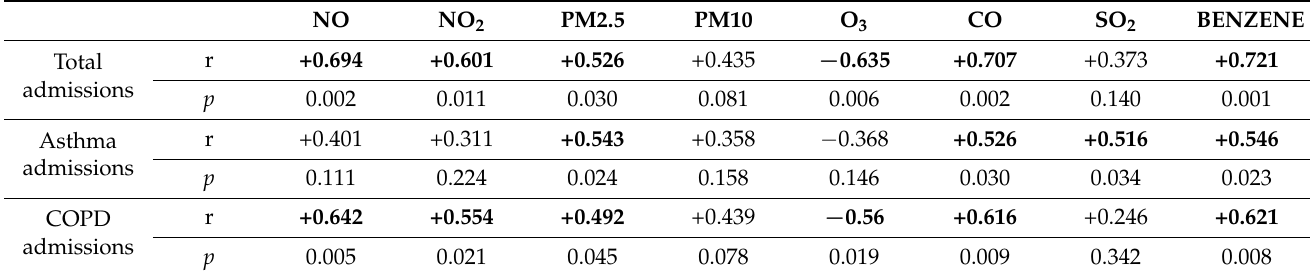
Table 4. Spearman’s correlation coefficients for air pollutants and admissions for